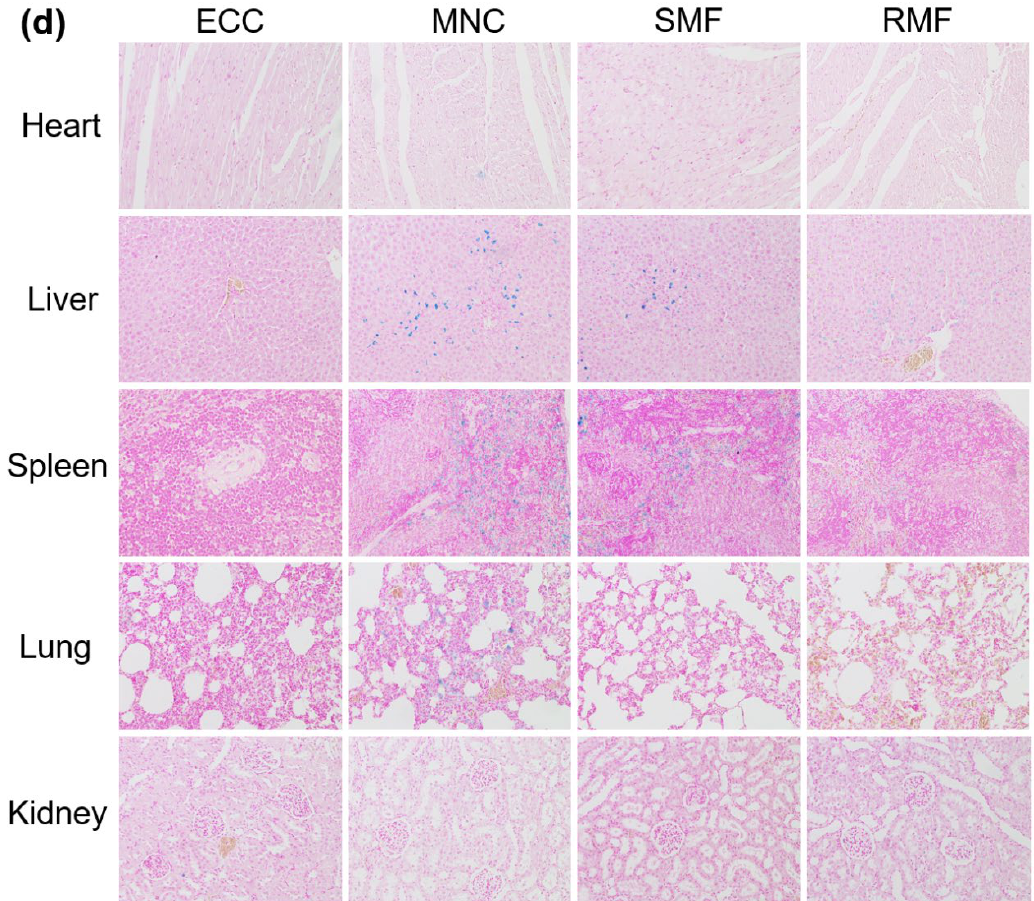
Figure 5. In vivo distribution of the nanochains on rats with the strategy of extracorporeal circulation plus magnetic separation. ( a ) Experimental scheme of the extracorporeal circulation plus the magnetic separation. ( b ) Exterior appearance of the magnetic separation chamber. Black sediments indicated by the red arrow were the separated magnetic nanochains. ( c ) HE staining images ( × 200) of main organs (rat) in different groups. ( d ) Prussian blue and nuclear fast red staining images ( × 200) of main organs (rat) in different groups. (ECC: Extracorporeal circulation, 2–3 mL of heparin sodium saline solution was pumped in; MNC: Magnetic nanoparticle chain, 2–3 mL of FA-MNCs-Dox heparin sodium saline solution was pumped in; SMF: Statistic magnetic field, 2–3 mL of FA-MNCs-Dox heparin sodium recovery; RMF: Rotating magnetic field, 2–3 mL of FA-MNCs-Dox heparin sodium